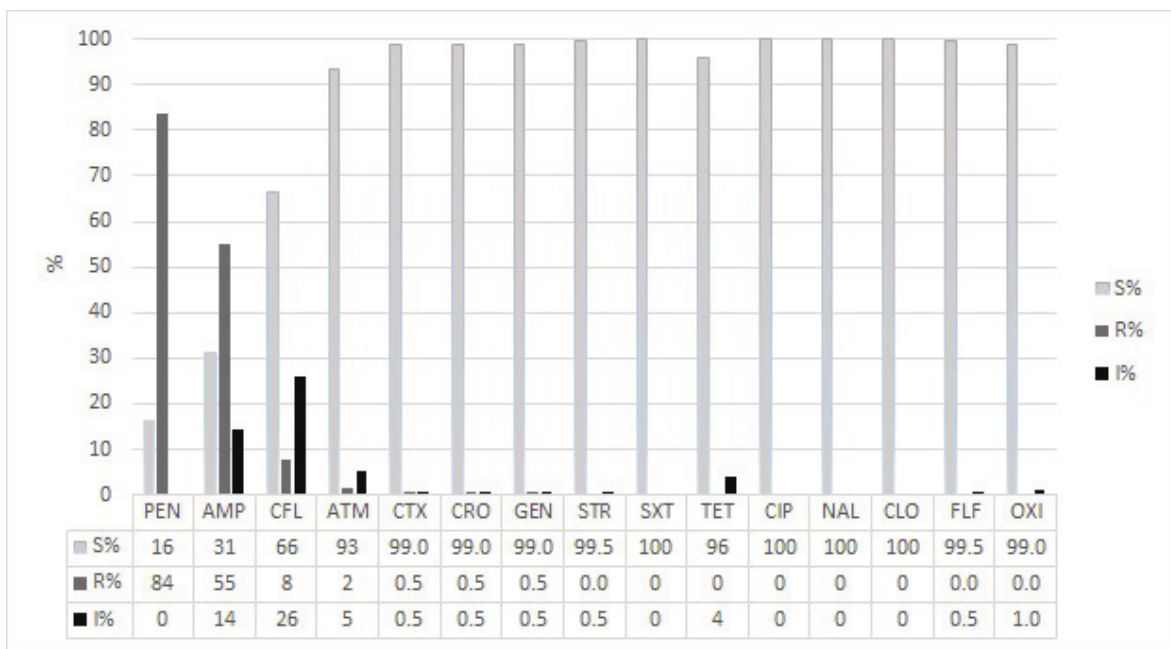
Figure 2 - Percentage of susceptibility to different antimicrobial of 197 strains of Vibrio spp. isolated from water and sediment from the estuaries of Pacoti, Choró, Pirangi and Jaguaribe rivers (Ceará). PEN – Penicillin; AMP - Ampicillin; CFL – Cephalothin; ATM – Aztreonam; CTX - Cefotaxime; CRO - Ceftriaxone; GEN - Gentamicine; STR - Streptomycin; SXT –trimethoprim∕ sulfamethoxazole; TET – Tetracycline; CIP –Ciprofloxacin, NAL- Nalidixic acid; CLO, Chloramphenicol; FLF, Florfenicol; OXI, Oxytetracyclin. S% = Sensible, R% = Resistant, I% =